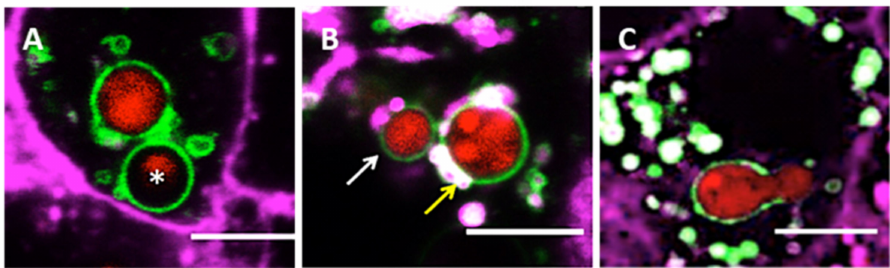
Figure 2. A. fumigatus fate within phagolysosomes of A549 alveolar epithelial cells at 18 h post- infection. ( A ) Digested spore (asterisk). ( B ) Resting (white arrow) and swollen spore (yellow arrow) inside the phagolysosome. ( C ) Germinated spore within phagolysosome. Scale Bar = 5 µ m. Magenta = airway epithelial cells membrane (CellMask Deep Red), Green = lysosomes (GFP-LAMP), red = A. fumigatus (MFIGRag29, Table S1).